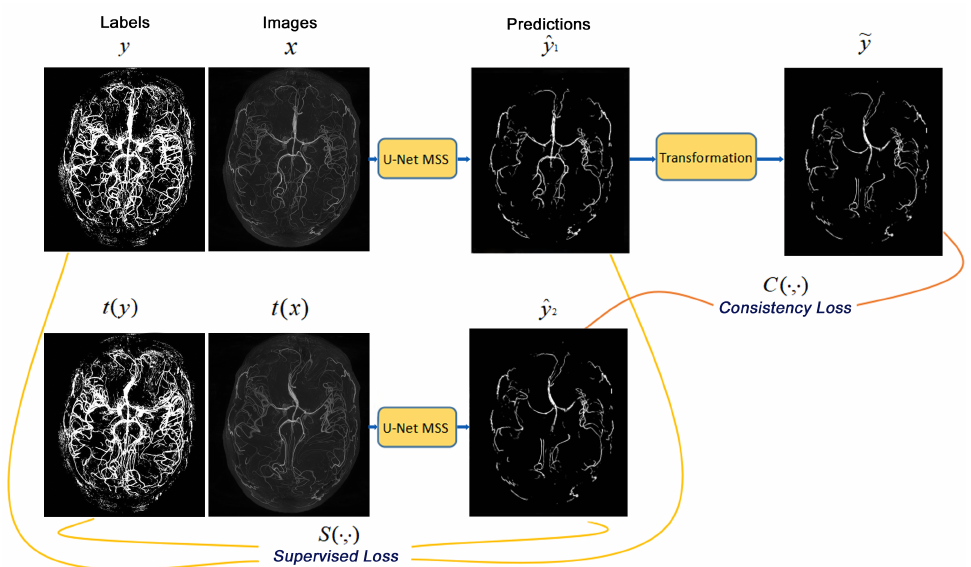
Figure 2. The proposed network is based on Siamese architecture, using modified U-Net MSS as the backbone. The original input is fed to the first branch while the second branch receives the elastically deformed version of the input, both branches use the same U-Net MSS for segmentation. The segmentation output of the first branch is elastically deformed using a differentiable transformation layer and is then compared with the output of the second branch for consistency (images shown here are only representative and do not portray real